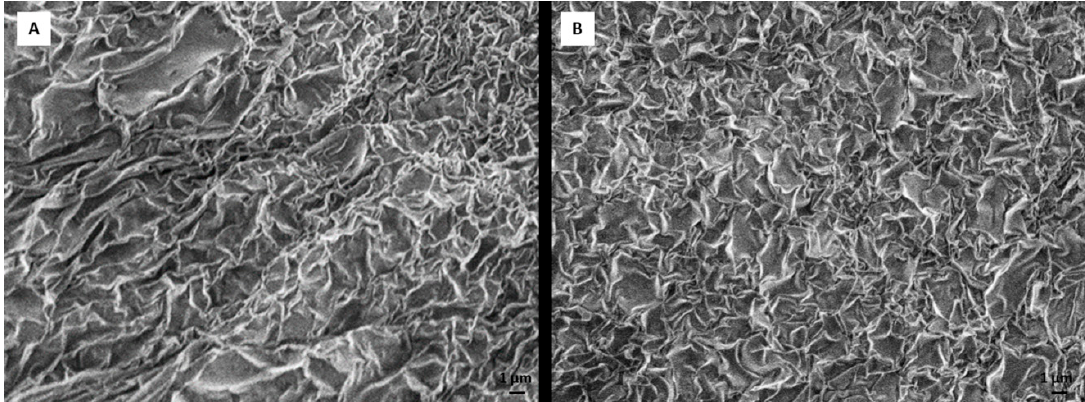
Figure 1. Scanning electron microscopy (SEM) images of 0.5% RADA 16-I peptide hydrogel 24 h after hydrogel polymerization, ( A ) without dexamethasone and ( B ) with dexamethasone. Scale bar represents 1 µm.